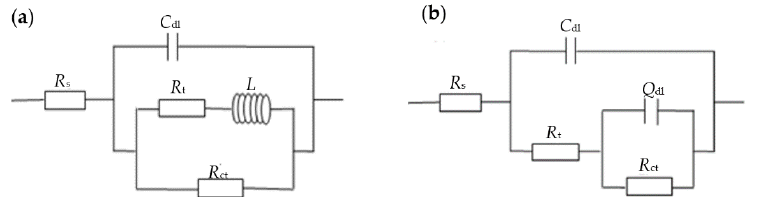
Figure 7. EIS equivalent circuits of AlCoCrFeNiZr x ( x = 0, 0.1, 0.2, 0.3, and 0.5) alloys in a 0.5 M H 2 SO 4 solution: ( a ) x = 0, 0.1, 0.3, and 0.5; ( b ) x = 0.2. Table 6. EIS equivalent circuit parameters of AlCoCrFeNiZr x ( x = 0, 0.1, 0.2, 0.3, and 0.5) alloys in a 0.5 M H 2 SO 4 solution. Alloy